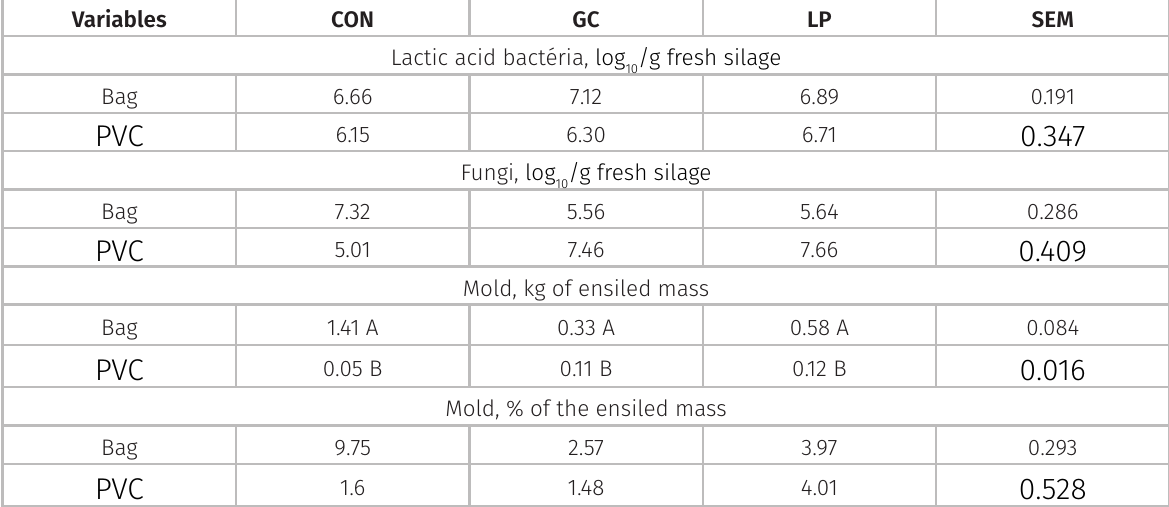
Table VII. Effects of additives and silo type on microbial populations of pearl millet silage.